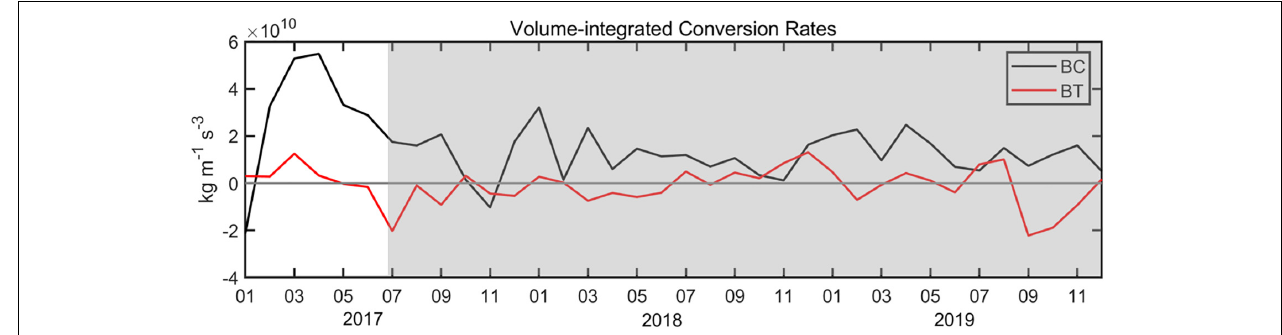
FIGURE 4 | Time series of two conversion rates volume-integrated (upper 1,000 m) over the area (30 ◦ –35 ◦ N, 132 ◦ –140 ◦ E). LM path periods are